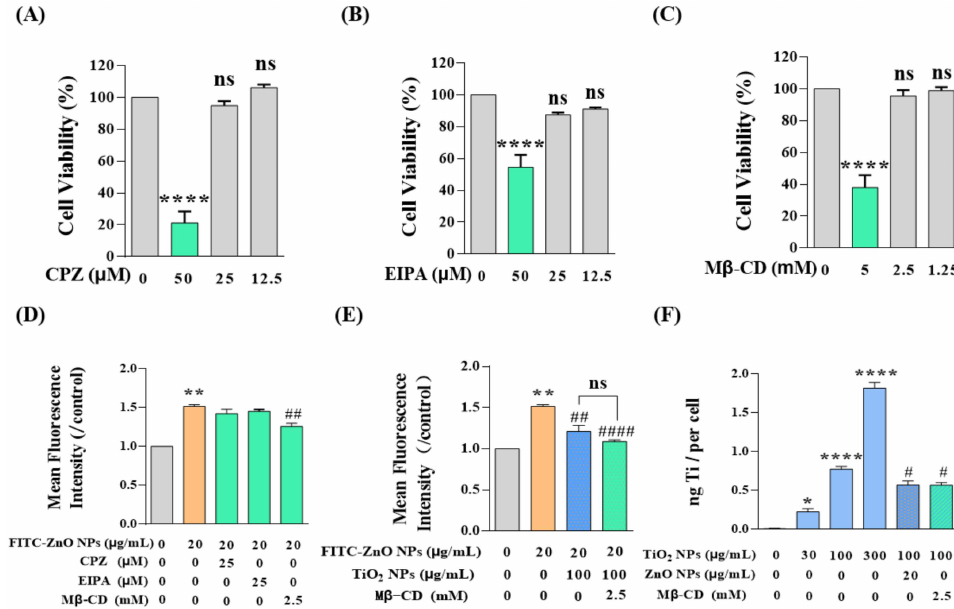
Figure 6. TiO 2 NPs restricted the cellular uptake of non-aggregated ZnO NPs by competing for caveolae- mediated endocytosis. ( A – C ) The appropriate doses of inhibitors determined by CCK-8 assay were CPZ ≤ 25 µ M ( A ), EIPA ≤ 25 µ M ( B ), and M β -CD ≤ 2.5 mM ( C ). ( D – E ) Intracellular FITC-ZnO NPs were detected by FCM after treatment with three endocytosis inhibitors with ( E ) or without ( D ) co- exposure of TiO 2 NPs. ( F ) Intracellular titanium contents on behalf of TiO 2 NPs were measured by ICP-MS. * p < 0.05, ** p < 0.01, **** p < 0.0001 compared to the control group. # p < 0.05, ## p < 0.01, #### p < 0.0001 compared to the single ZnO NP-treated group or the single TiO 2 NP-treated